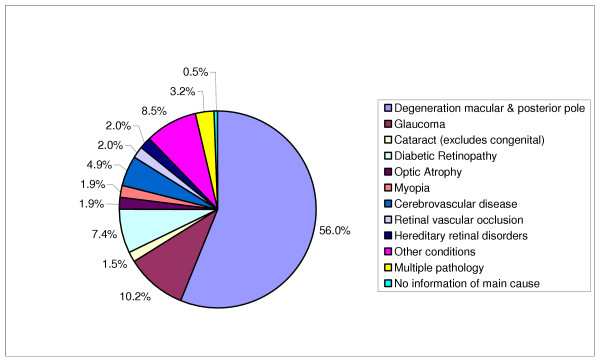
Causes of certifications for partial sight in England and Wales April 1999–March 2000.